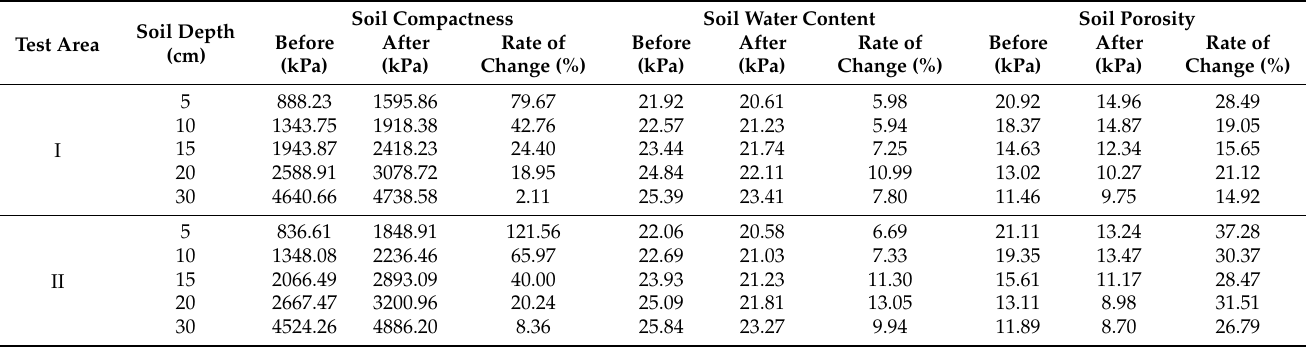
Table 2. Soil parameters of plough layer before and after compaction in each test